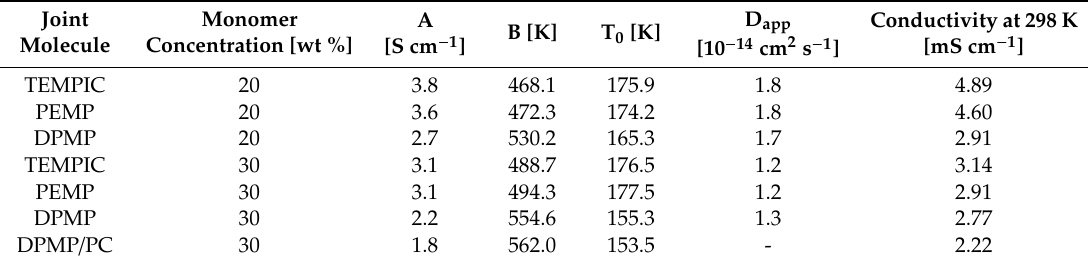
Table 3. Vogel–Tammann–Fulcher (VTF) equation parameters and apparent lithium ion di ff usion coe ffi cients (Dapp) for ionic